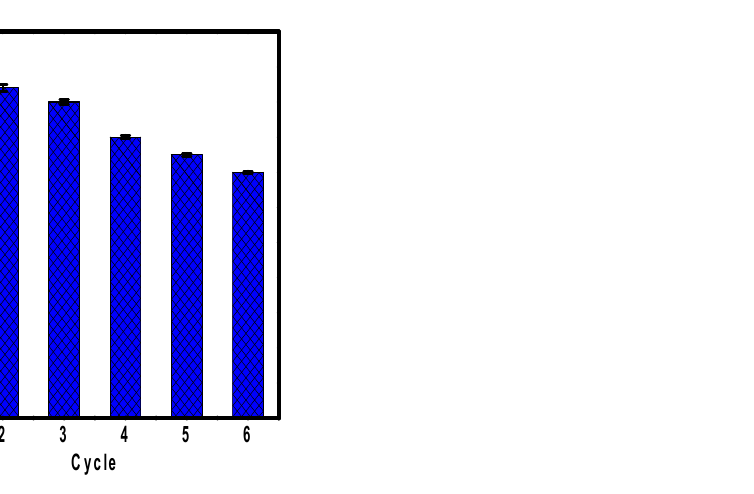
Figure 8. The reusability study of ppy/NC nanocomposite for the removal of Cr(VI) ions up to six successive cycles.